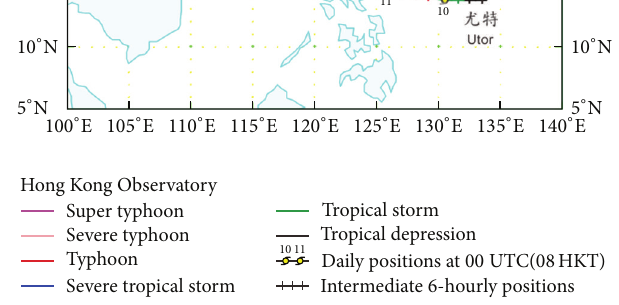
Figure 2: Track map of tropical cyclone Utor (1311)on 9 to 16 August